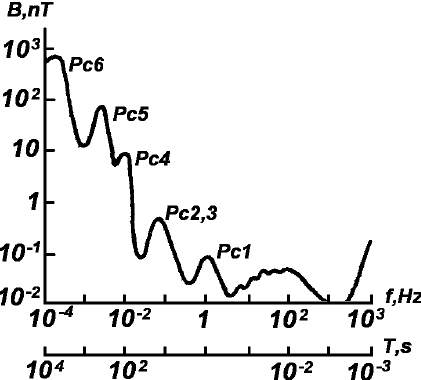
Fig. 7. Dependence of amplitude of geomagnetic pulsations on their frequencies and periods (modified from Janovsky,